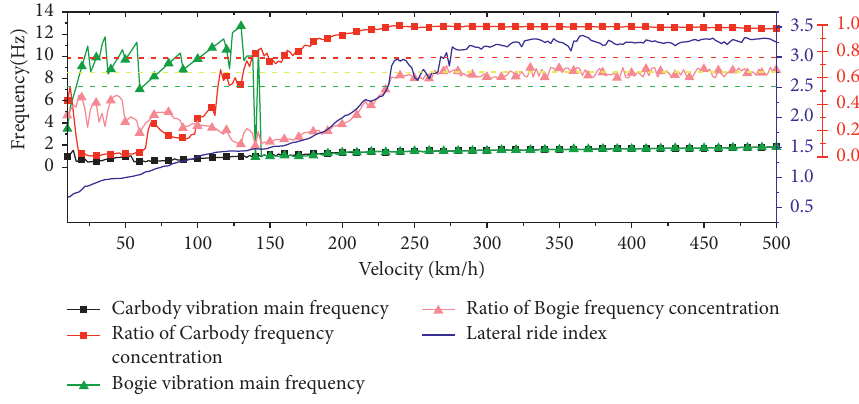
Figure 10: Carbody vibration characteristic and lateral ride